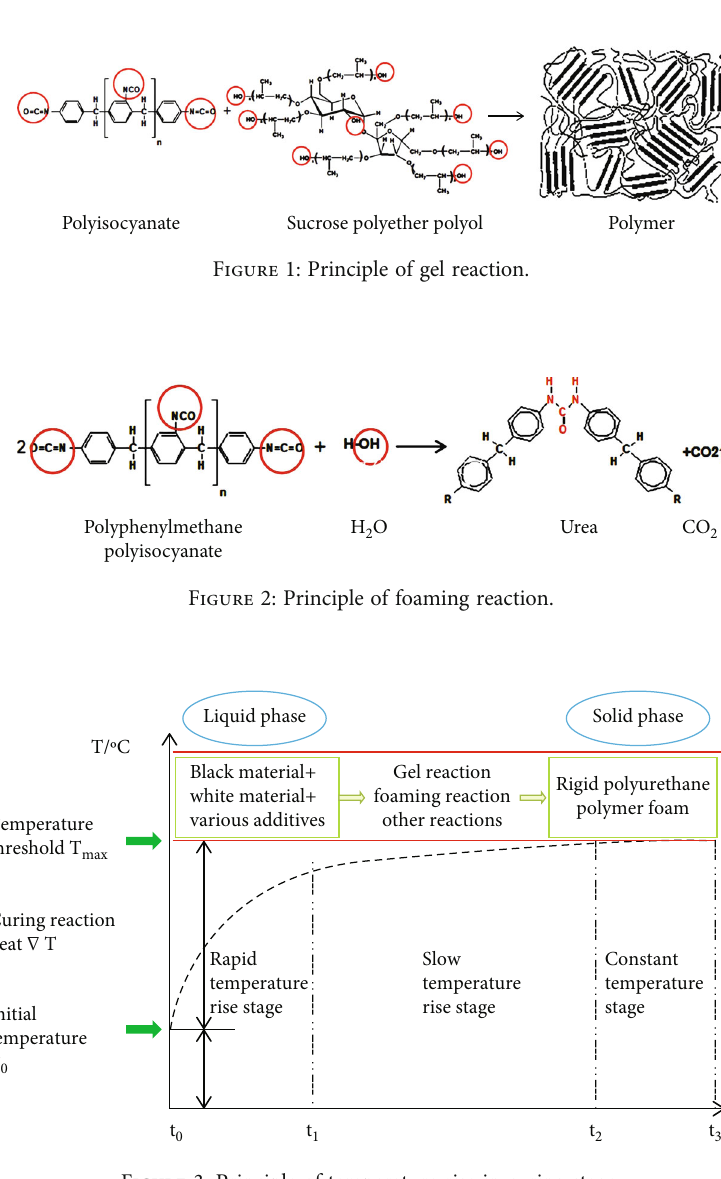
Figure 3: Principle of temperature rise in curing stage.